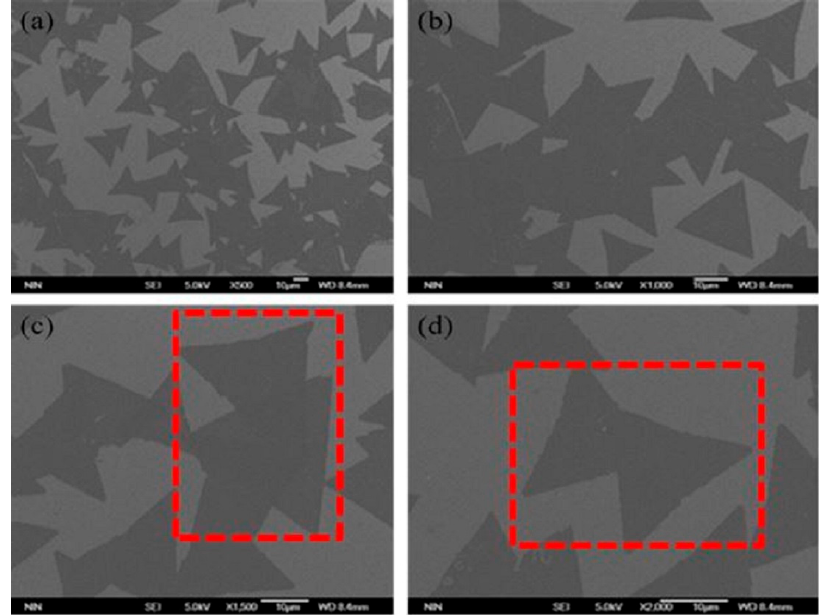
Figure 3. Field emission scanning electron microscope (FESEM) characterization of MoS2/WS2 vertical hetero-junction at different magnifications ( a ) 500×; ( b ) 1000×; ( c ) 1500×; ( d ) 2000×. hetero-junction at di ff erent magnifications ( a ) 500 × ; ( b ) 1000 × ; ( c ) 1500 × ; ( d ) 2000 × .